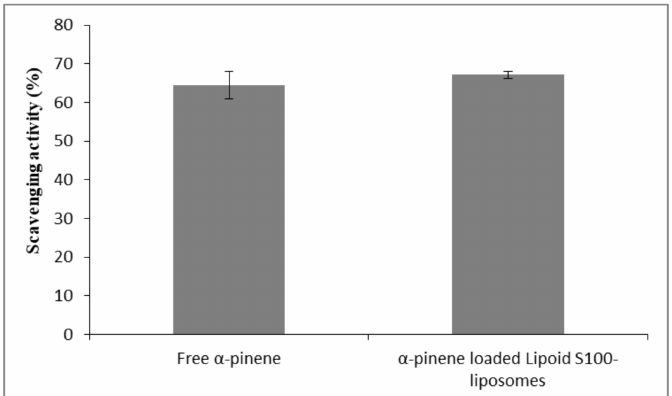
Figure 4. DPPH • scavenging activities of free α -pinene and α -pinene-loaded Lipoid S-100 liposomes measured at α -pinene concentration of 200 µ